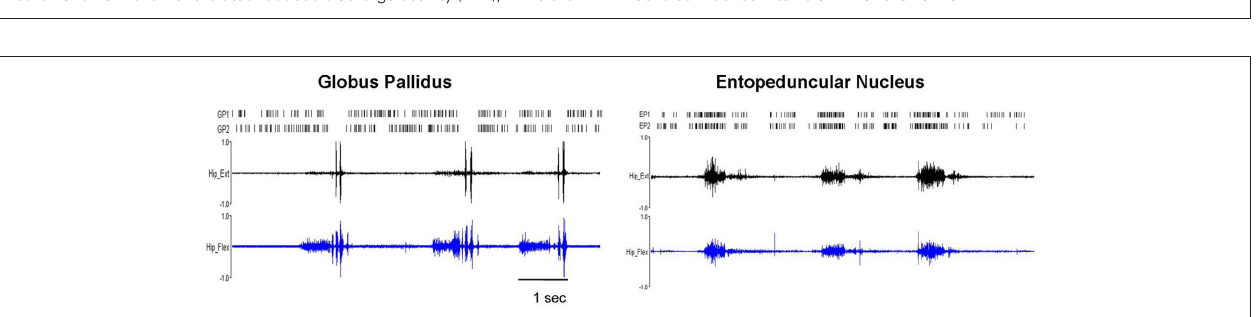
Figure 4 | Multi-unit discharge activity during movement in normal and dystonic animals. (A) In normal rats, movement related increases in neuronal discharge activity (illustrated for GP, but also in EP and STN) were dominated by brief bursts which recurred in relation to individual agonist or antagonist EMG epics ( p < 0.001). In dystonic rats, movement related increases in discharge were characterized by prolonged bursts mostly persisting over multiple dystonic co-contraction epics ( p < 0.001). (B) The pattern of movement related decreases in neuronal discharge activity (illustrated for EP) was similar in normal and dystonic animals. Note that in the illustrated example for a dystonic rat, one neuron shows movement related reduced discharge activity (EP2), while the